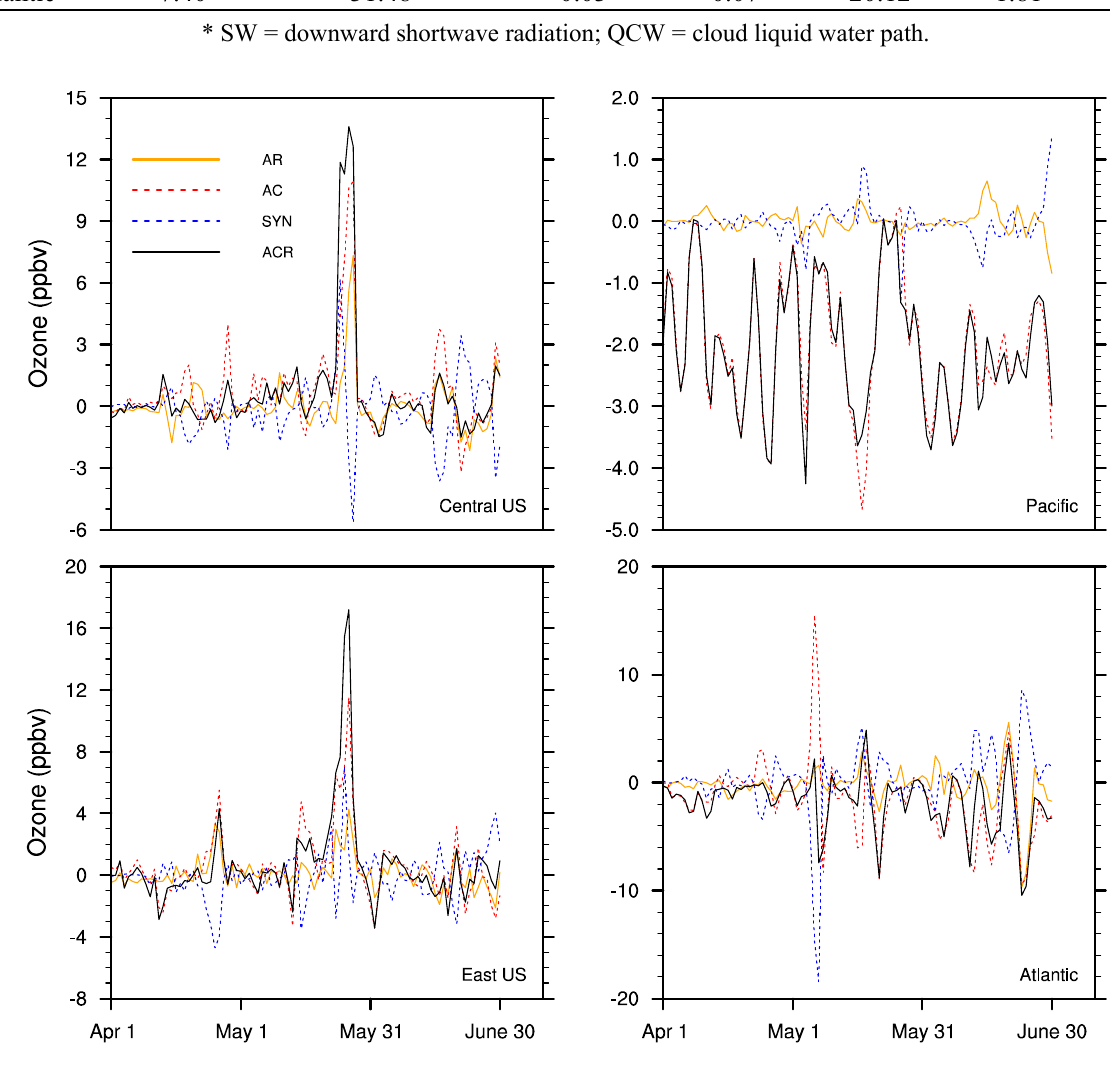
Figure 10. Temporal distributions of changes in surface ozone concentrations (ppbv) due to AC, AR, SYN, and ACR for the selected regions highlighted in red boxes of Figures 8 and